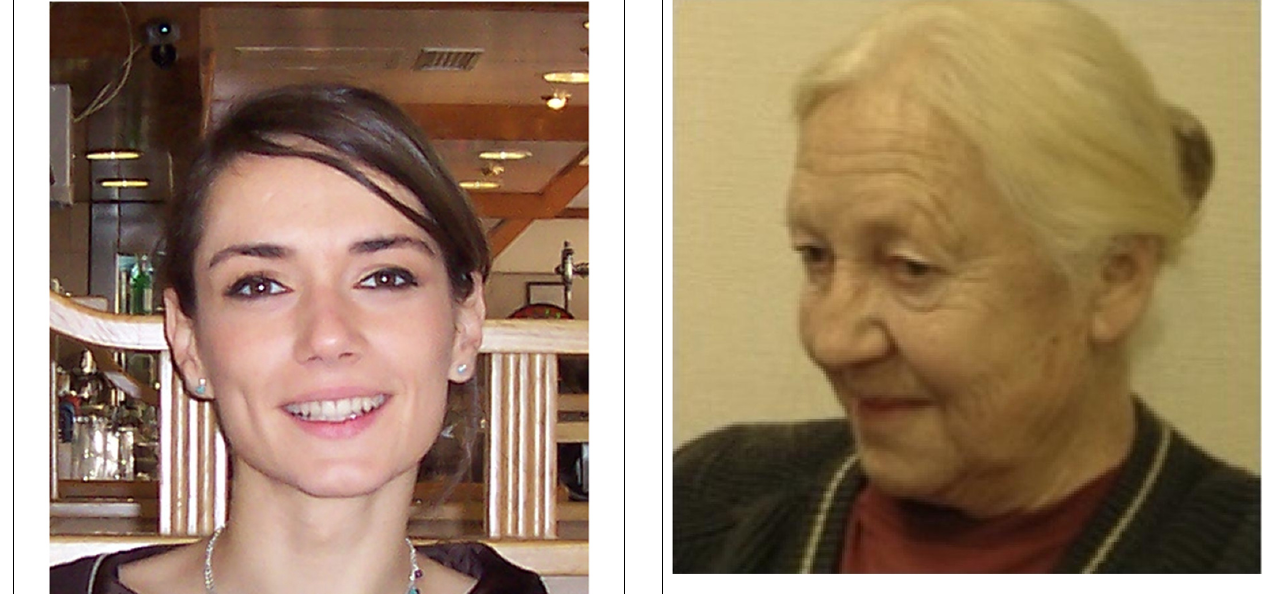
FIGURE 8 | Laura Cif, provided by Laura Cif.